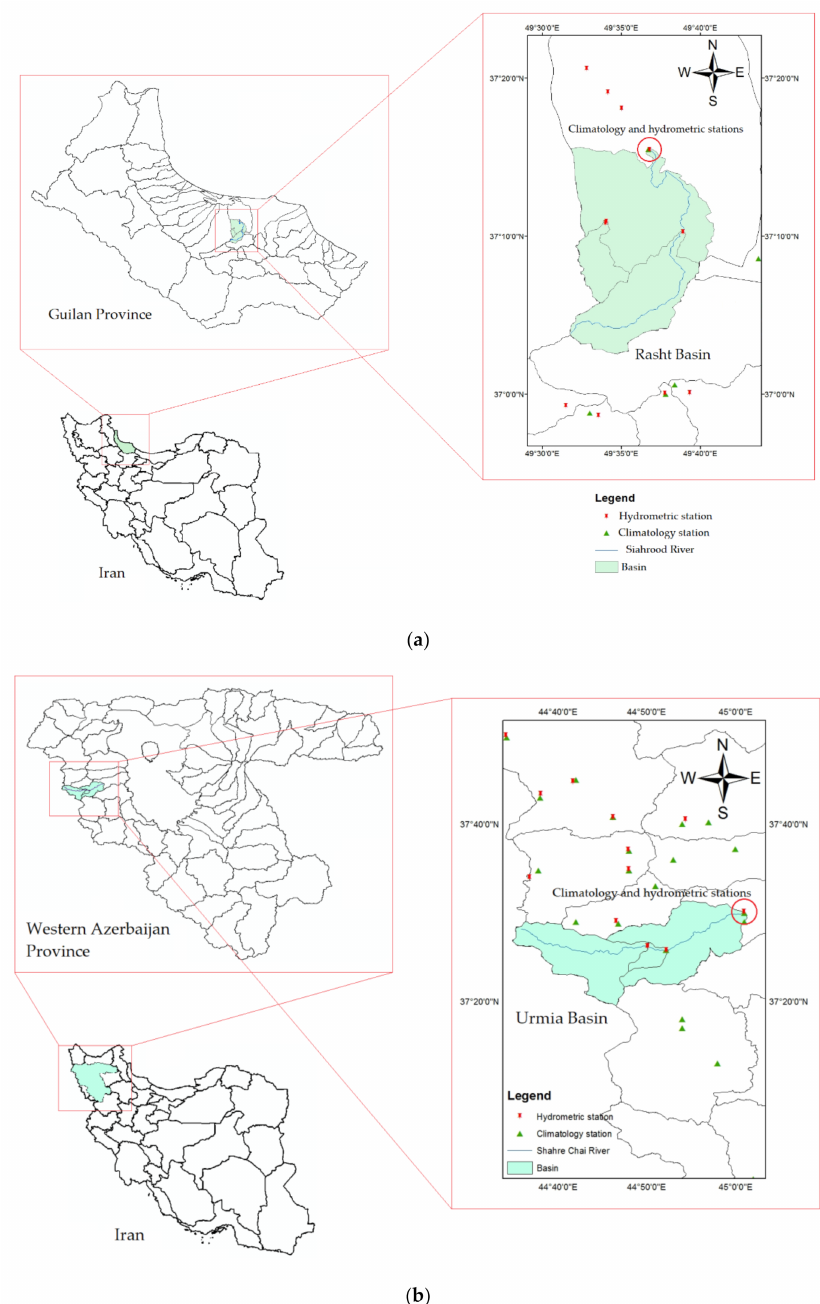
Figure 2. Position of climatology and hydrometric stations in: ( a ) Rasht Basin, Iran; and ( b ) Urmia Basin,